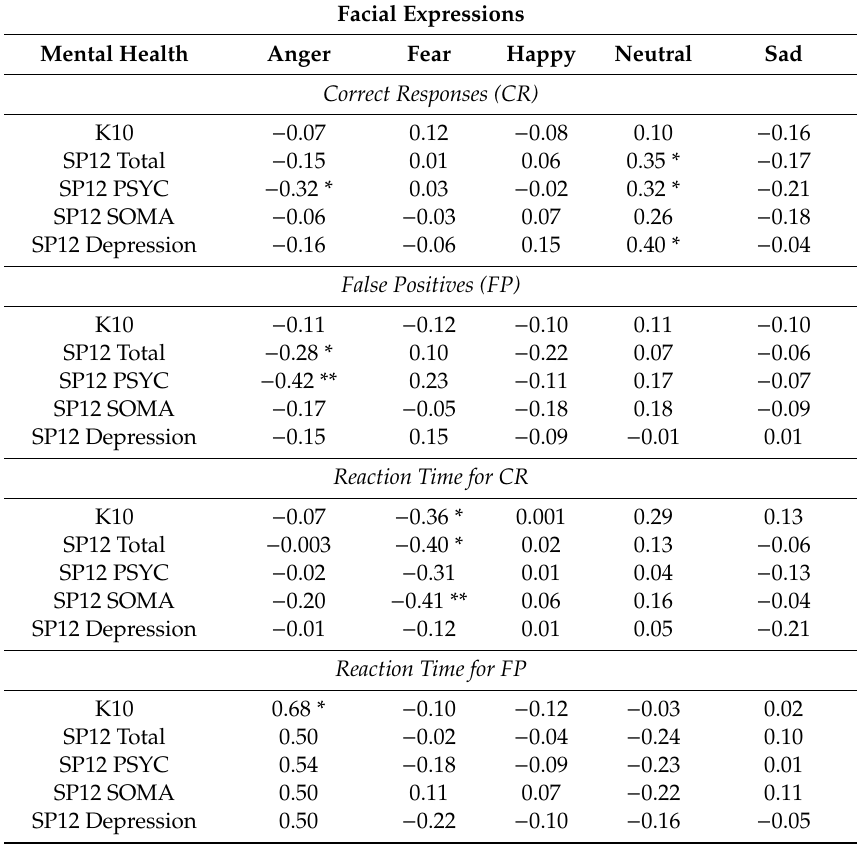
Table 2. Correlations between mental health and emotion recognition Facial